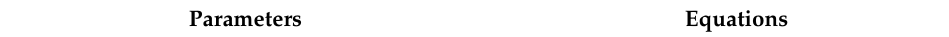
√ 4 ac − b 2 √ = 0 c 2 b S 0 = − 2 c √ 4 ac − b 2 = R √ 2 c c